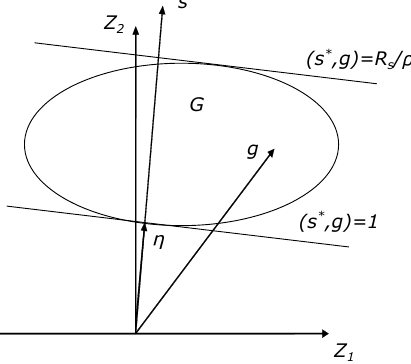
Figure 3. The set G and its characteristics.